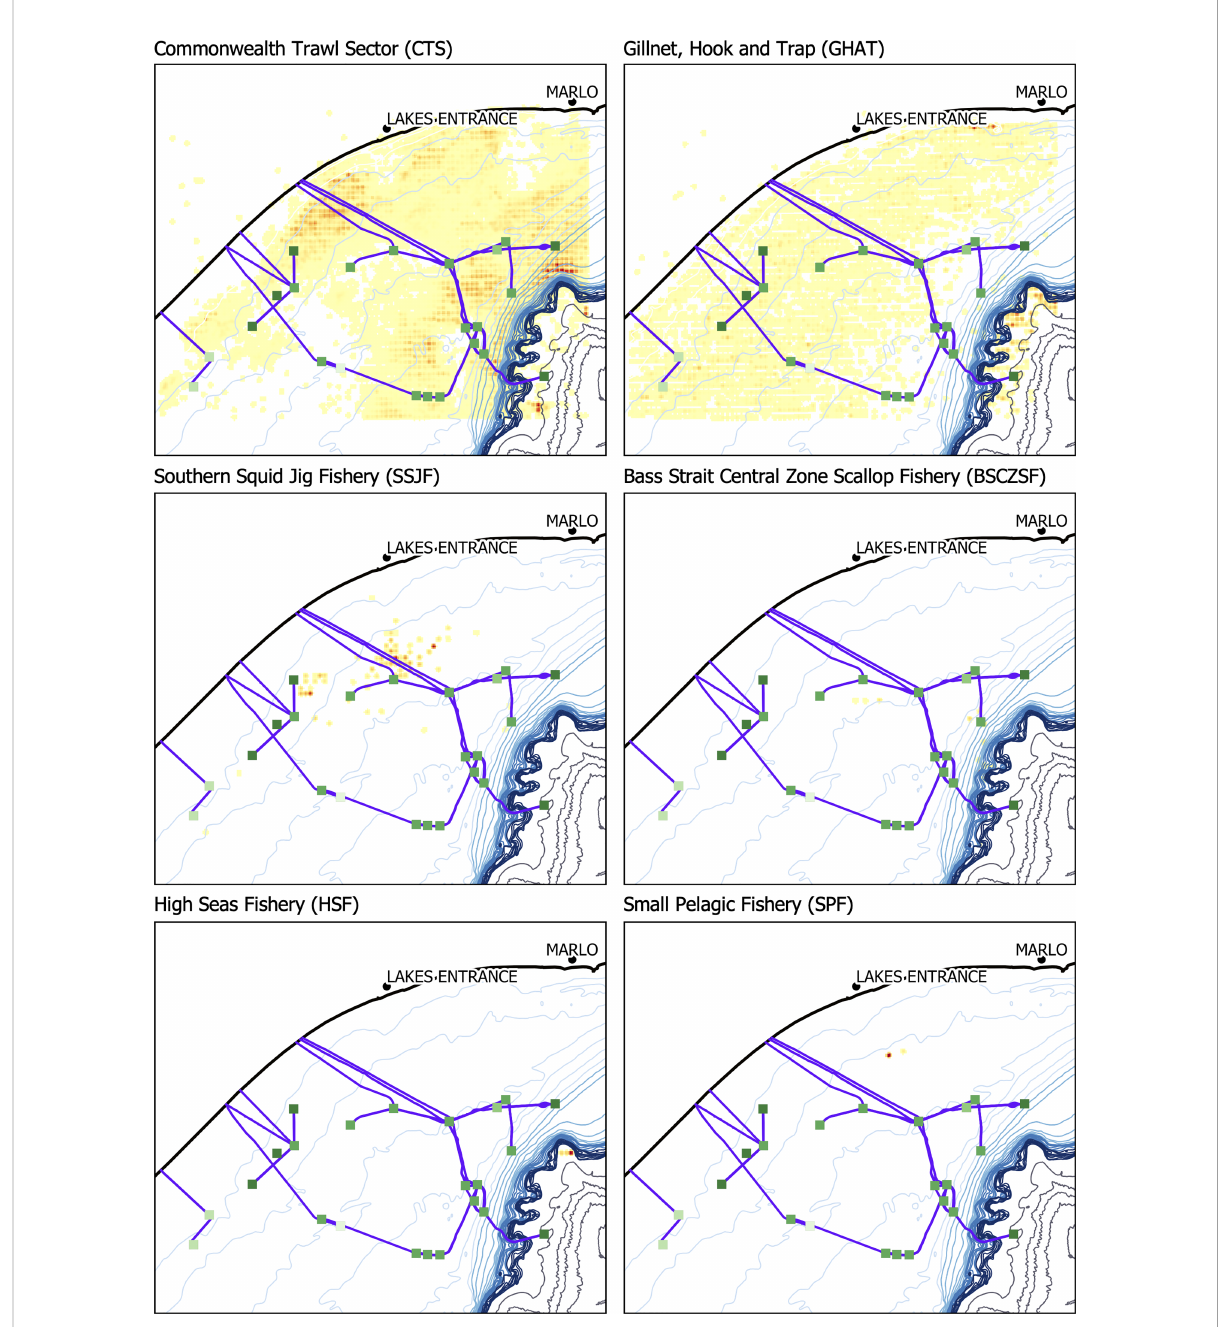
FIGURE 5 Spatial distribution of fi shing effort for six Commonwealth fi sheries among the offshore oil and gas structures in the Gippsland Basin. Maps were made in QGIS. Individual versions of these maps with accompanying legends are included in the Supplementary